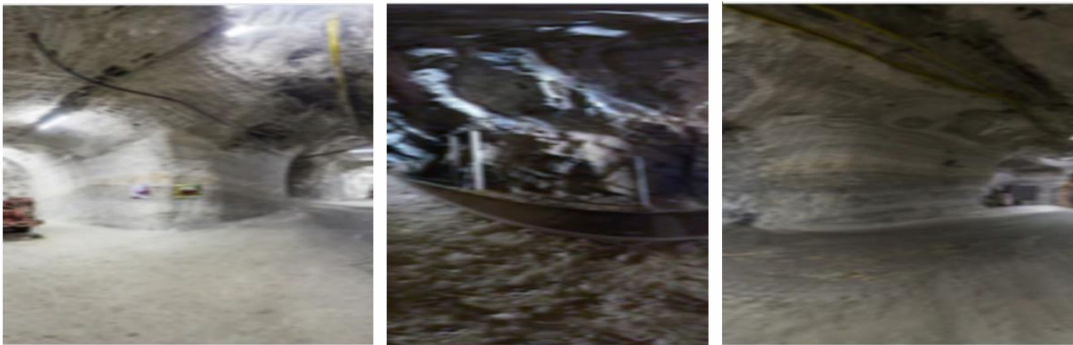
Figure 5. Example of still images from Sonderhausen mine, Germany